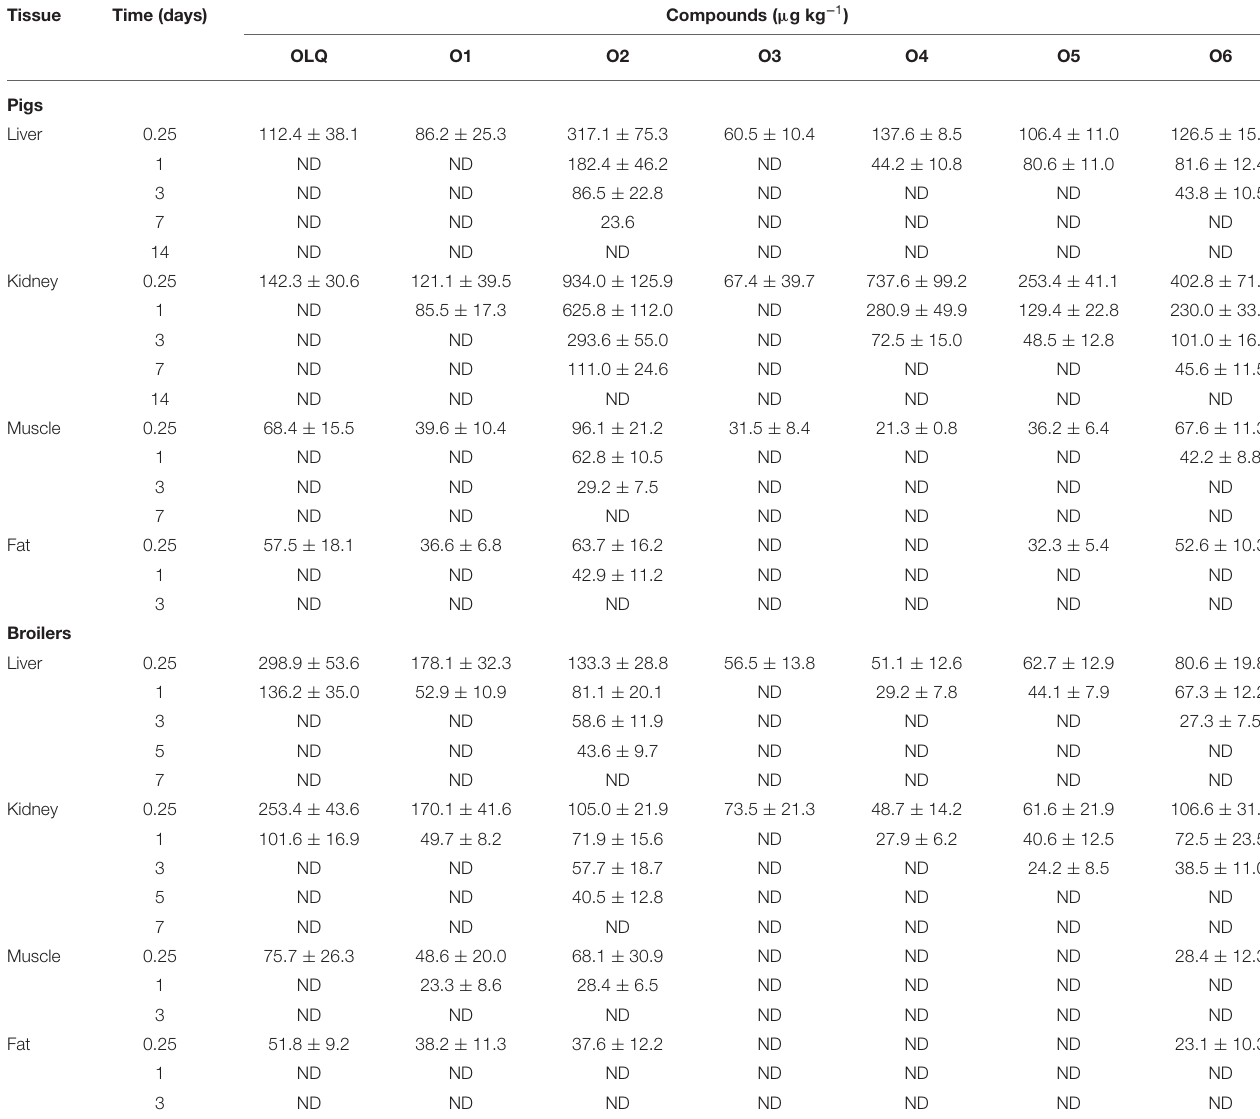
TABLE 1 | Concentrations of olaquindox and its metabolites in edible tissues of pigs ( n = 5) and broilers ( n = 6) at different days after being fed with olaquindox for 14 consecutive days.